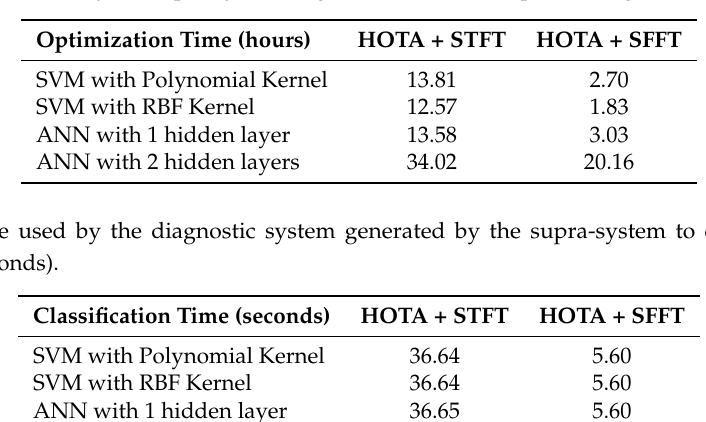
Table 3. Time needed by the supra-system to generate each local optimal diagnostic system (hours).